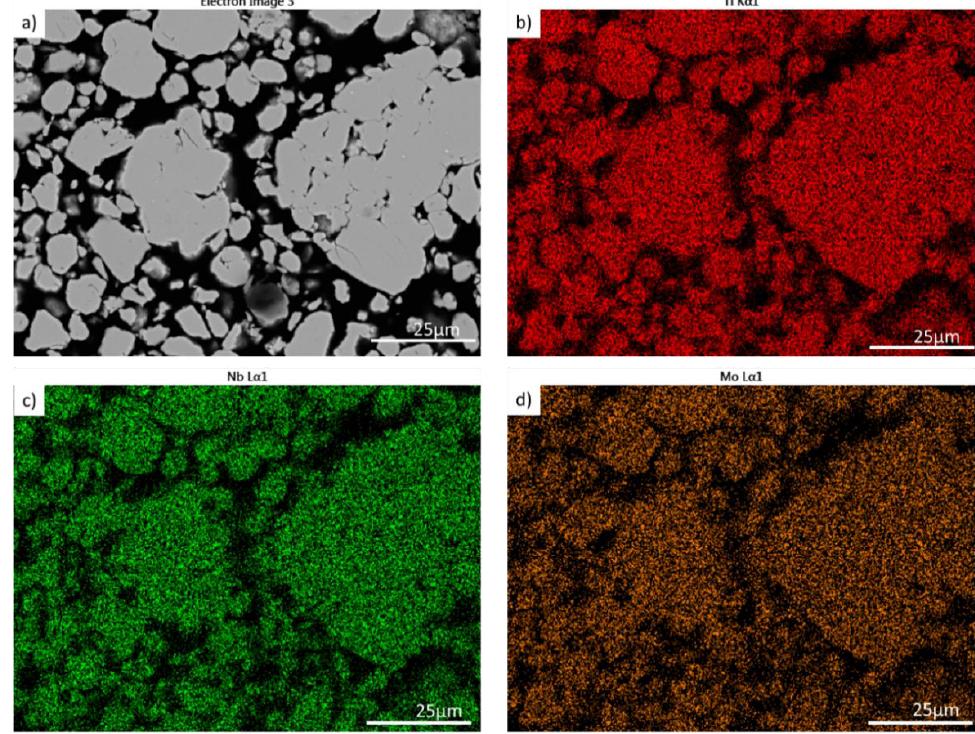
Figure 5. The SEM-EDS elemental map analysis for the Ti–Nb–Mo powders milled at 60 h: ( a ) electron image, ( b ) Ti K α , ( c ) Nb L α , ( d ) Mo L α Table 4. Oxygen content obtained during the milling process.